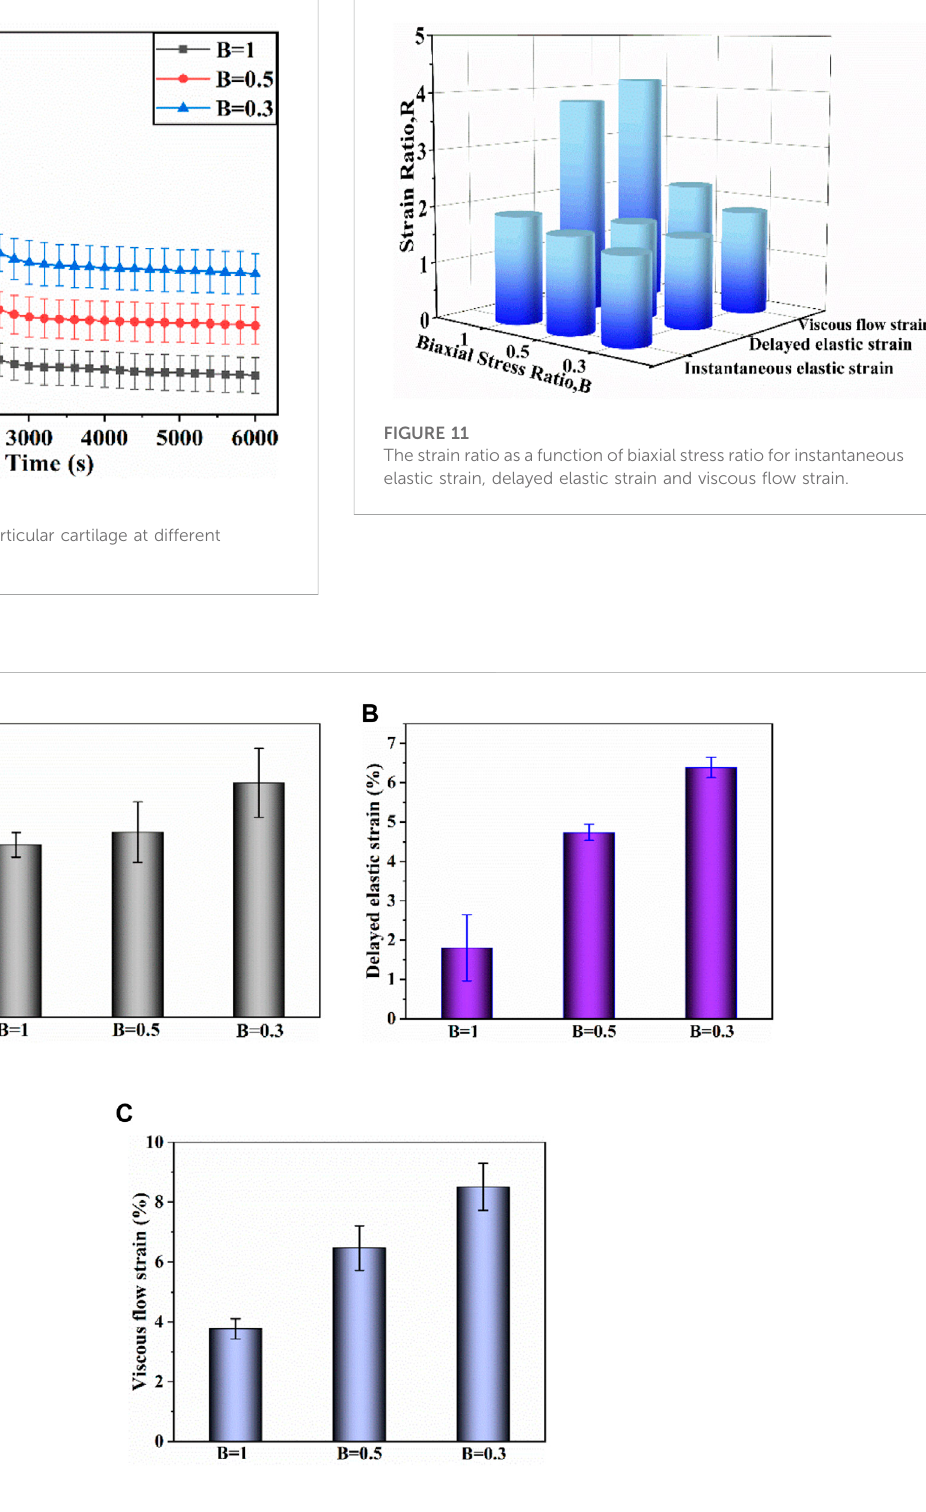
components. As shown in Figure 5D, by comparing the percentage of each strain component, the contribution of each strain component at different stress levels was evaluated. Decrease in proportion of